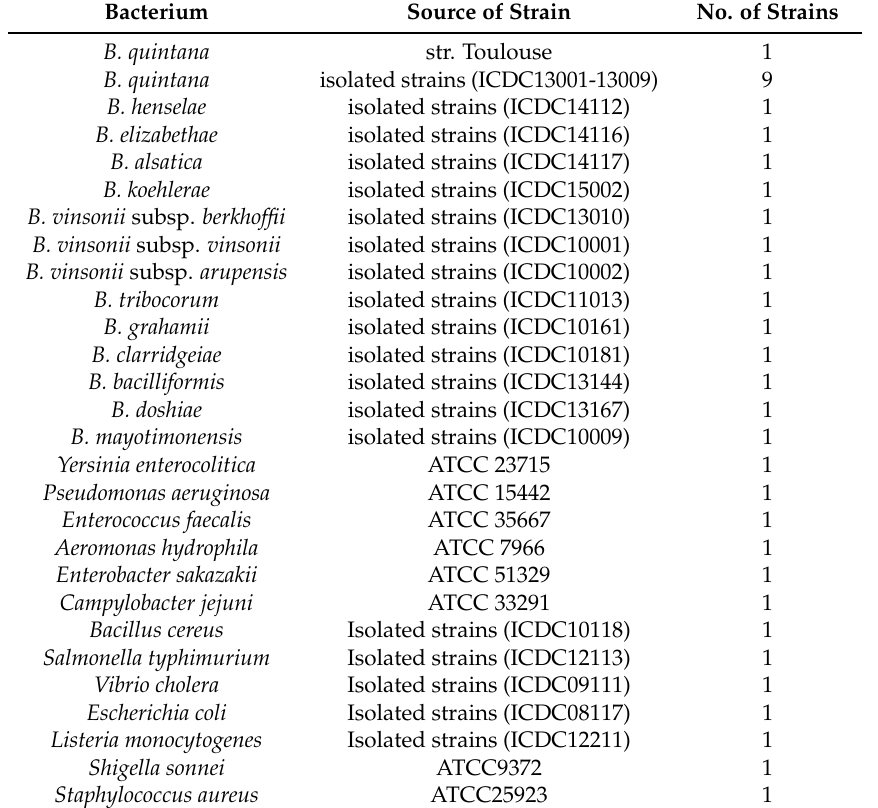
Table 3. Bacterial strains used in this